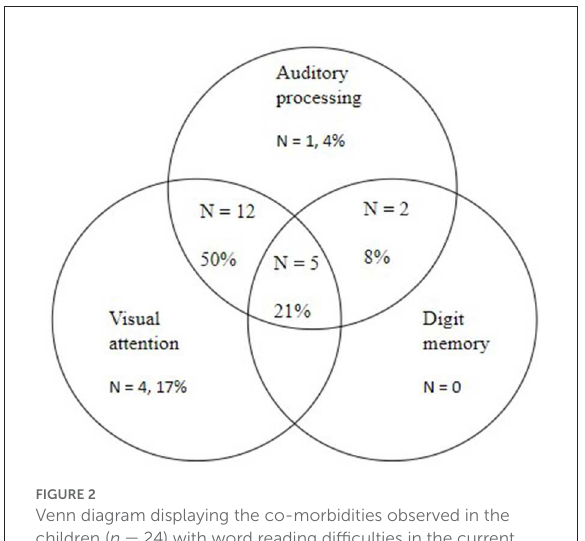
FIGURE2 Venn diagram displaying the co-morbidities observed in the children ( n = 24) with word reading difficulties in the current study.